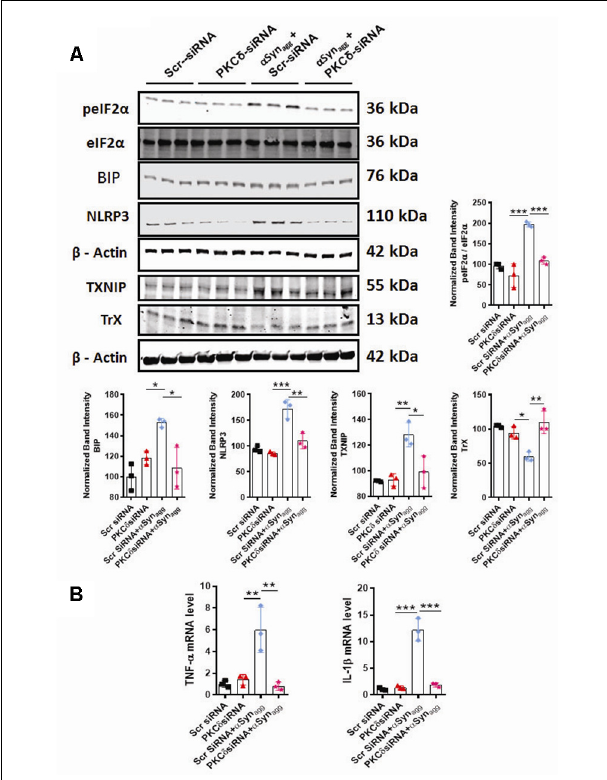
FIGURE 7 | siRNA-mediated TXNIP knockdown mitigates NLRP3 inflammasome activation markers in primary microglial cells stimulated with α Syn agg . (A) Expression of caspase-1 and NLRP3 inflammasome activation marker in mouse PMG transfected with TXNIP siRNA for 48 followed by stimulation with α Syn agg for another 24 h. Western blot analysis and quantification reveals inhibitory effects of TXNIP siRNA on α Syn agg -induced upregulation of NLRP3 and cleaved caspase-1 in mouse PMG as compared with scramble siRNA transfected cells. β -actin used as an internal control. (B) qRT-PCR analysis of IL-1 β and TNF- α in mouse PMG transfected with or without TXNIP siRNA with or without stimulation with α Syn agg for 24 h. TXNIP siRNA attenuated α Syn agg -induced upregulation of the aforementioned proinflammatory cytokine gene expression as compared to scramble transfected mouse PMG. Data shown are the mean ± SEM from at least three independent experiments. Significance is based on two-way ANOVA followed by a Bonferroni post hoc test. *** p < 0.001 and * p < 0.05 vs.